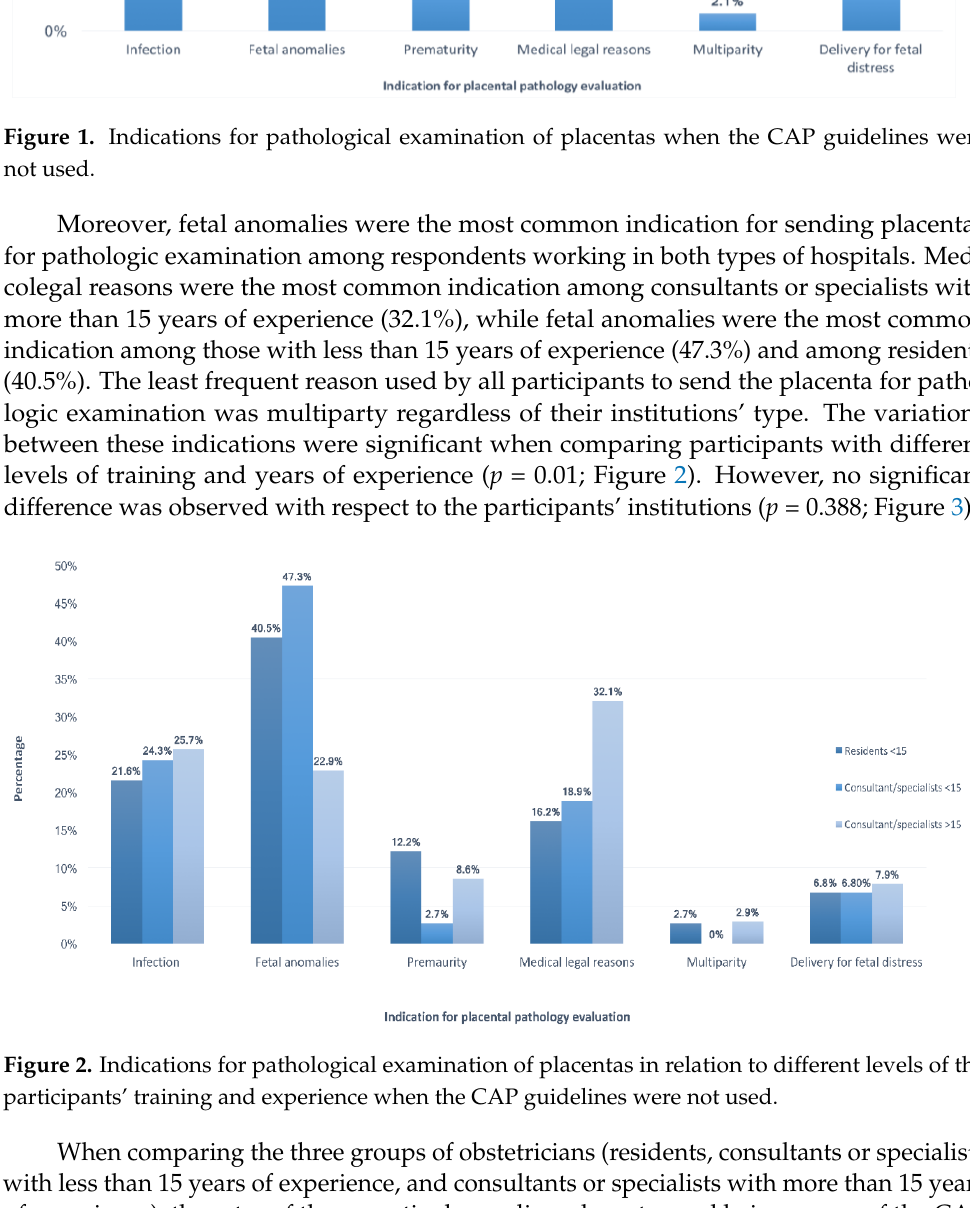
Figure 3. Indication for pathological examination of placentas in relation to different institutions when the CAP guidelines were not used. When comparing the three groups of obstetricians (residents, consultants or special- ists with less than 15 years of experience, and consultants or specialists with more than 15 years of experience), the rates of those routinely sending placentas and being aware of the CAP guidelines were found to be approximately similar (Table 5). In contrast, there was a significant difference among the participants in their appreciation of the clinical useful- ness of the CAP guidelines, which was the highest among the consultants and specialists with less than 15 years of experience. The multivariate analysis (Table 6) revealed that the odds of CAP guidelines aware- ness for the consultants or specialists were 0.866 times higher than the odds of the aware- ness of the residents. Similarly, the odds of sending the placenta for pathologic examina- tion and appreciating the usefulness of the CAP guidelines were, respectively, 0.445 and 2.920 times those applicable for residents. Similarly, for the respondents with more than 15 years of experience, the odds of the awareness of the CAP guidelines and of sending a placenta for pathologic examination were 0.564 and 0.529 times higher than the odds ap- plicable for those with less than 15 years of experience. Moreover, the odds of appreciating the usefulness of the CAP guidelines were 1.512 times higher than the odds applicable for